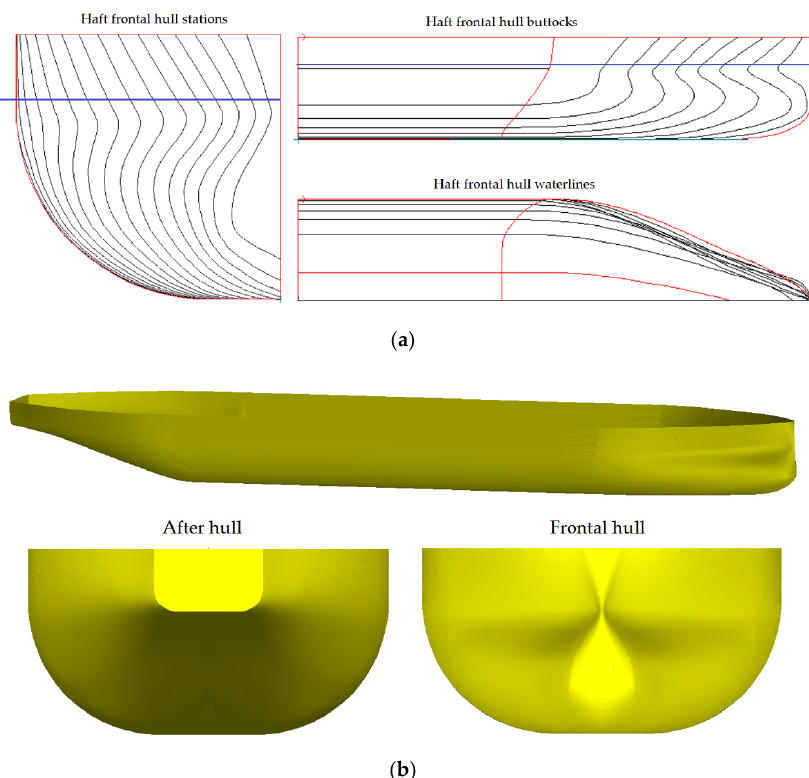
Figure 6. Models of NBS with a bulbous bow used for simulation. ( a ) Haft frontal body plan of the new bulbous bow model; ( b ) new proposed model used for CFD computation.